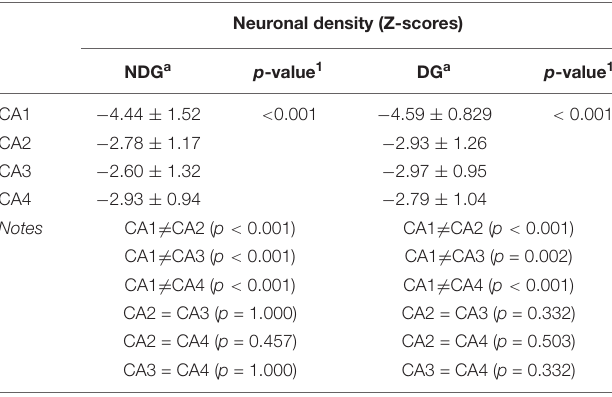
TABLE 5 | Neuronal densities of the four hippocampal sectors, in Z -scores, comparing each main group (depression and non-depression) internally. Neuronal density (Z-scores)